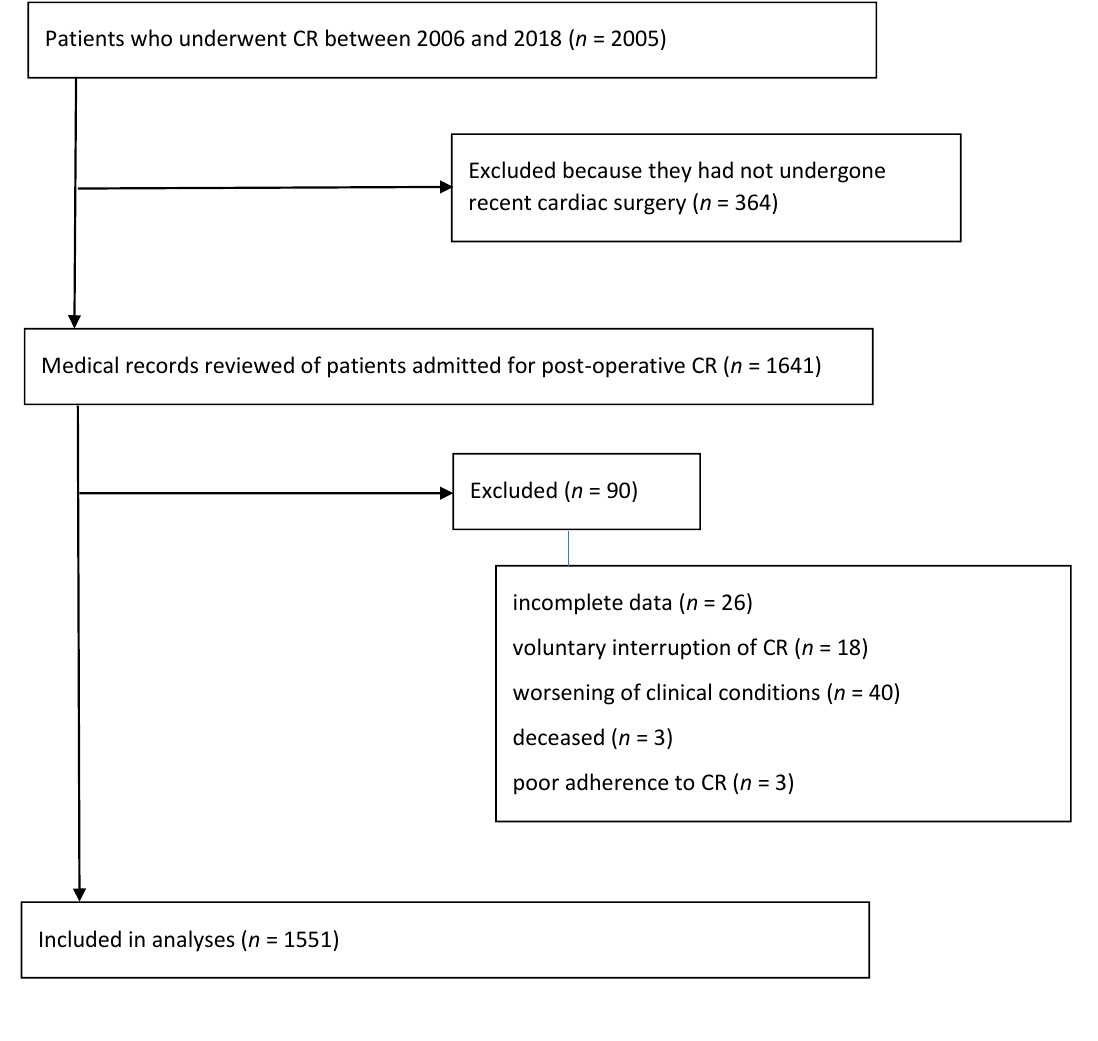
Figure 1. A flowchart of the patients’ records reviewed for eligibility. A total number of 1551 patients with complete pre-to-post data were included in the study, and their main characteristics by year are shown in Table 1. Overall, the average patient age was 70.2 years ( ± 9.7), and 66% were men ( n = 1018). Coronary artery bypass graft (CABG) and cardiac valve replacement surgery (CVS) were the most represented surgical procedures (41.1% and 35.8%, respectively), followed by plastic surgery of the mitral valve (10.3%); the remaining patients reported mixed conditions. The median index score of the chronic comorbidities was 2 (IQR 1;4), with hypertension (58.6%) and cardiac arrhythmias (43.2%) being the most frequent. The complications post-surgery were relatively few (see the details in Table 1). During their hospital stay (16 ± 3.6 days), the patients attended 13.2 ( ± 2.7) sessions of CR.